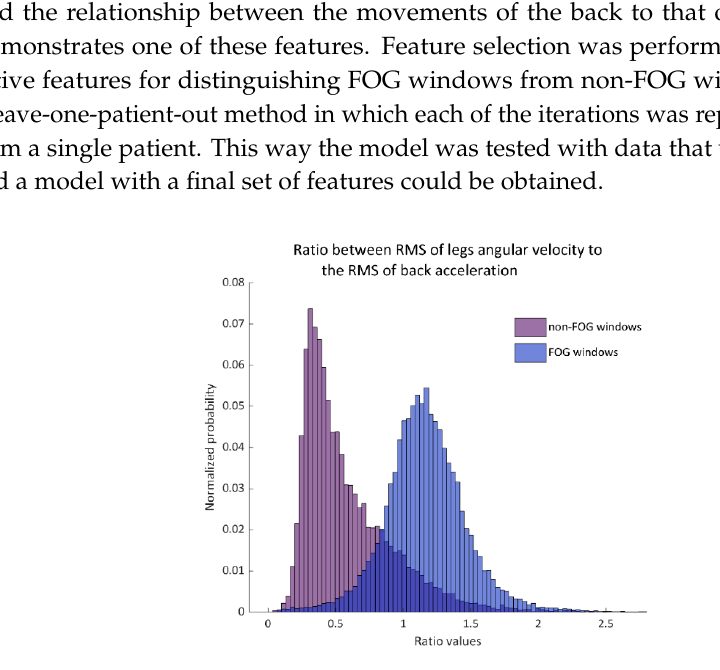
Figure 2. The histogram of the ratio between legs gyroscope root-mean-square (RMS) to the back-acceleration RMS in non-FOG windows (left histogram) and FOG windows (right histogram). This ratio was used as a primary input feature to the support vector machines (SVM) model. Probability is shown in normalized values.